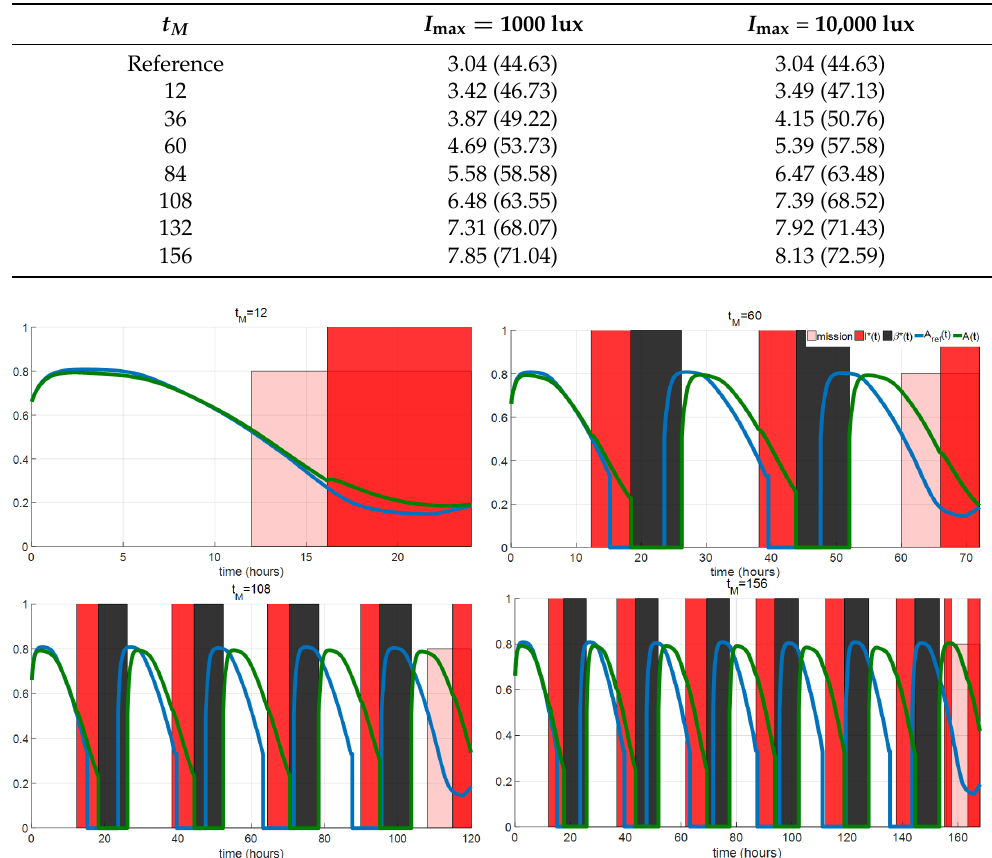
Figure 8. Alertness optimization results with I max = 10,000 lux and various mission beginning time t M . The pink regions show the mission period, the red and black regions show the optimal light exposure and sleep durations. Blue and green curves plots the reference alertness under periodic light in Equation (11) and optimal alertness solved by the gradient descent method in Section